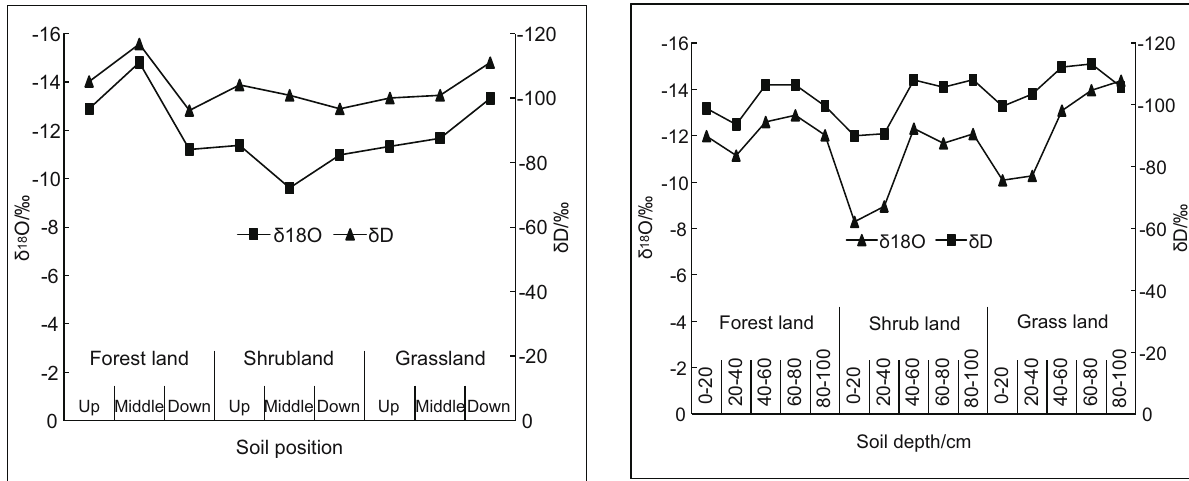
Figure 4: Composition of δ D and δ 18 O in the di ff erent soil water with di ff erent depths and